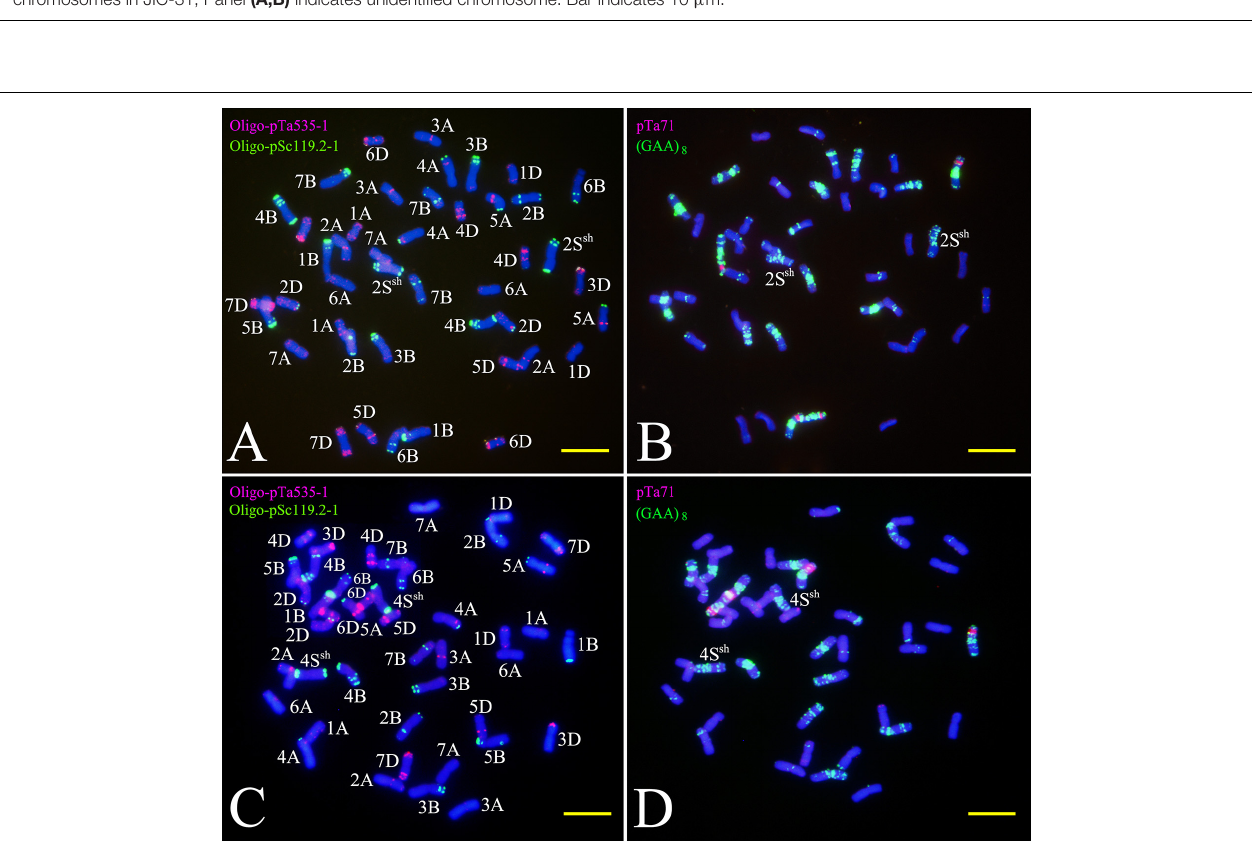
FIGURE 2 | FISH using Oligo-nucleotides as probes on the CS- A . sharonensis 2S sh disomic addition (A,B) and the 4S sh disomic addition (C,D) . Panels (A,C) are double-color FISH patterns using Oligo-pTa535-1 (red) and Oligo-pSc119.2-1 (green) as probes; (B,D) are double-color FISH patterns using pTa71 (red) and (GAA) 8 (green) as probes. Bar indicates 10 µ